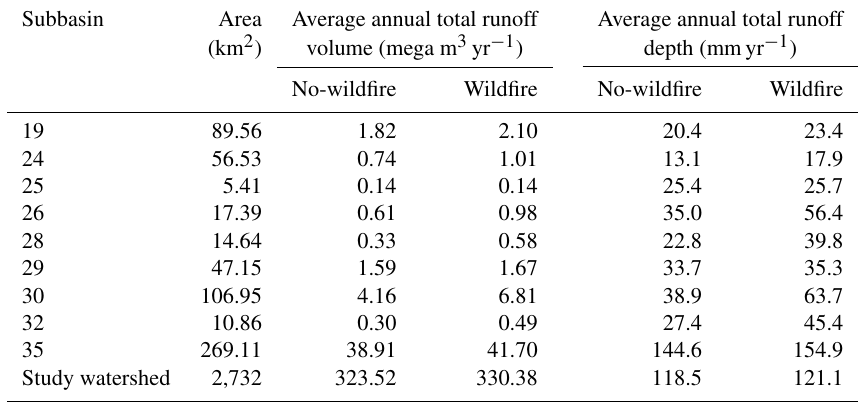
Table 4. Average annual total runoff volumes and depths for both the no-wildfire and fire scenarios, shown for the burned sub-watersheds as well as for the entire study watershed. Area is also include for